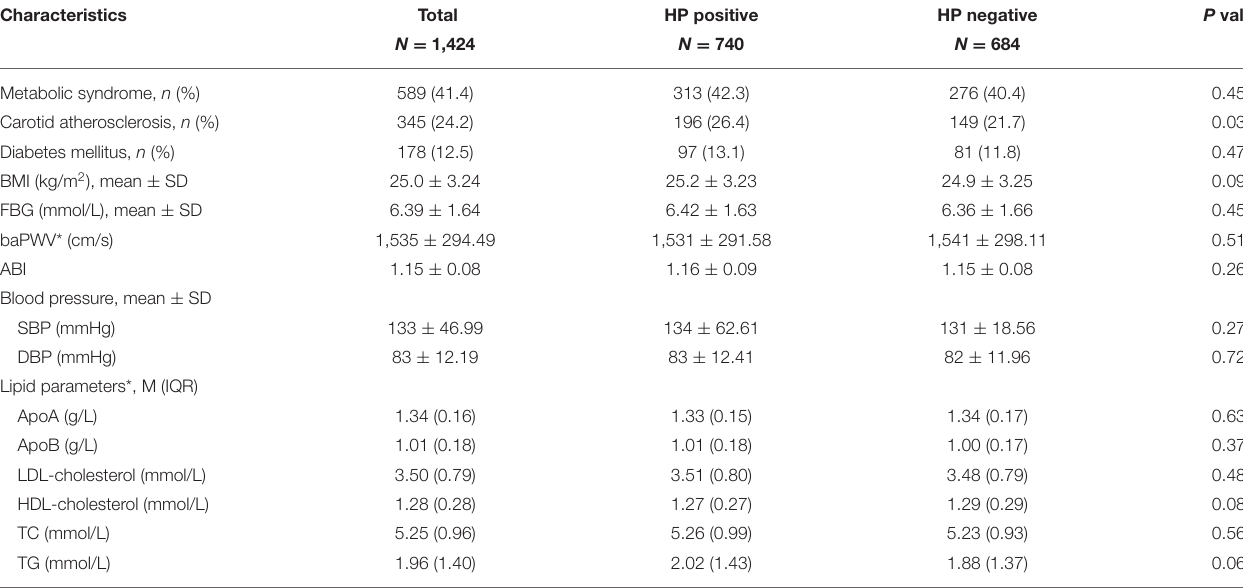
TABLE 2 | Comparison of disease and clinical indicators in participants with different statuses of HP infection. Characteristics